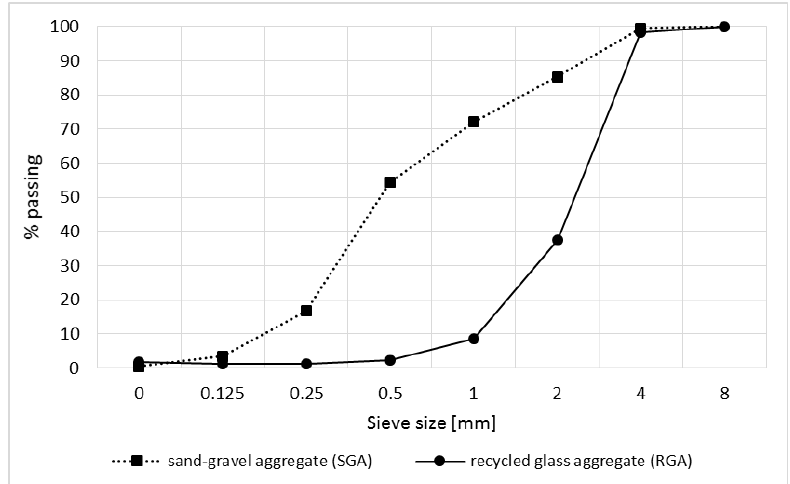
Figure 2. Particle size distribution of the aggregates used.